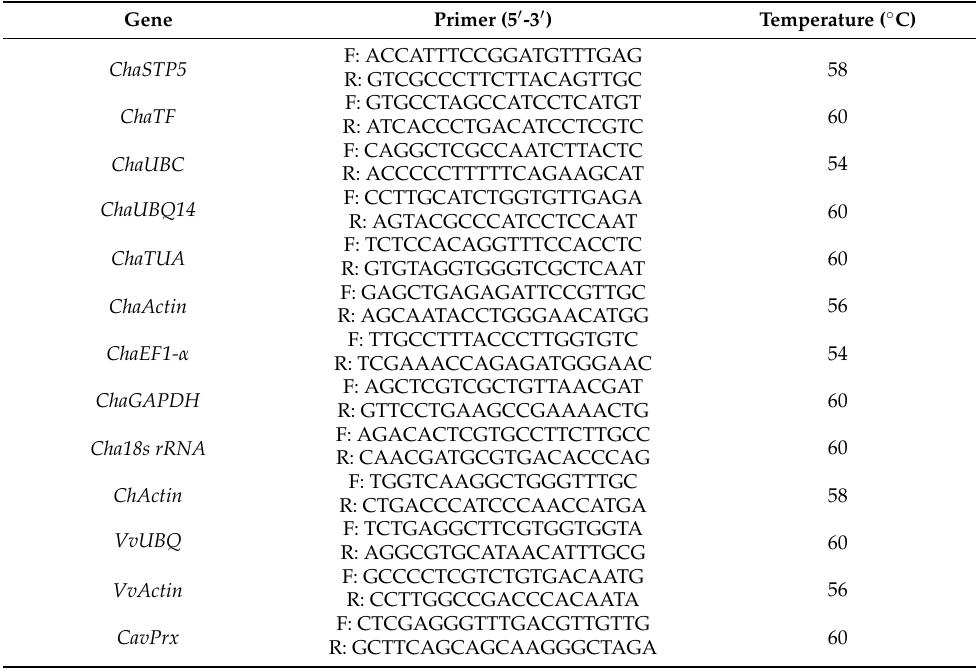
Table 10. RT-qPCR primer